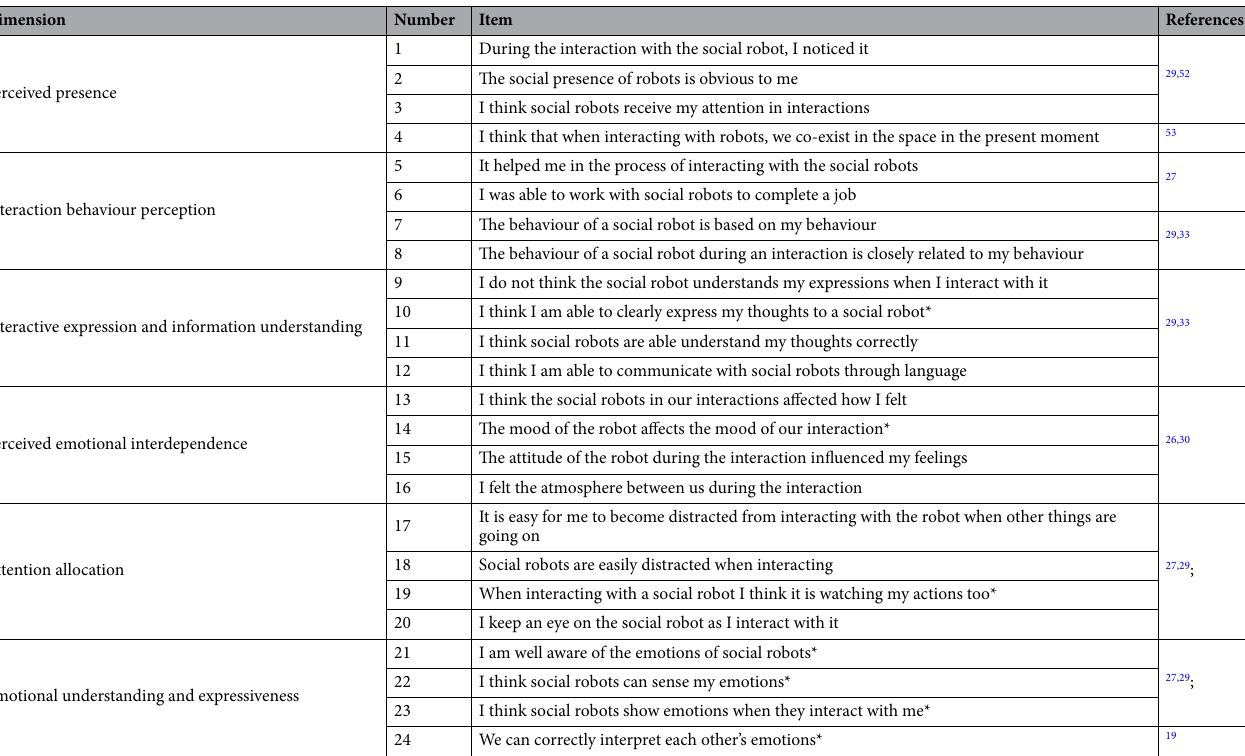
Table 3. The original scale of robots’ social presence. The whole scale is the initial scale developed according to the initial model. *indicates that the questions deleted after three rounds of survey. Non *questions are the items left after deletion.